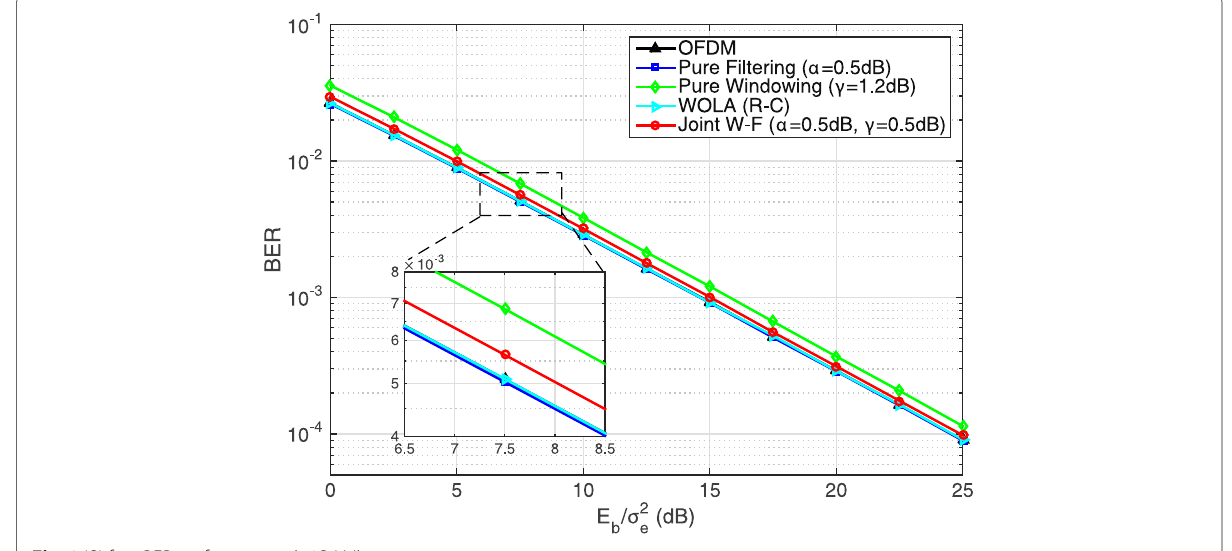
Some example methods of estimating CFOs can be found in [43, 44]. However, ICI will still occur because various CFOs of users are unable to be compensated for at